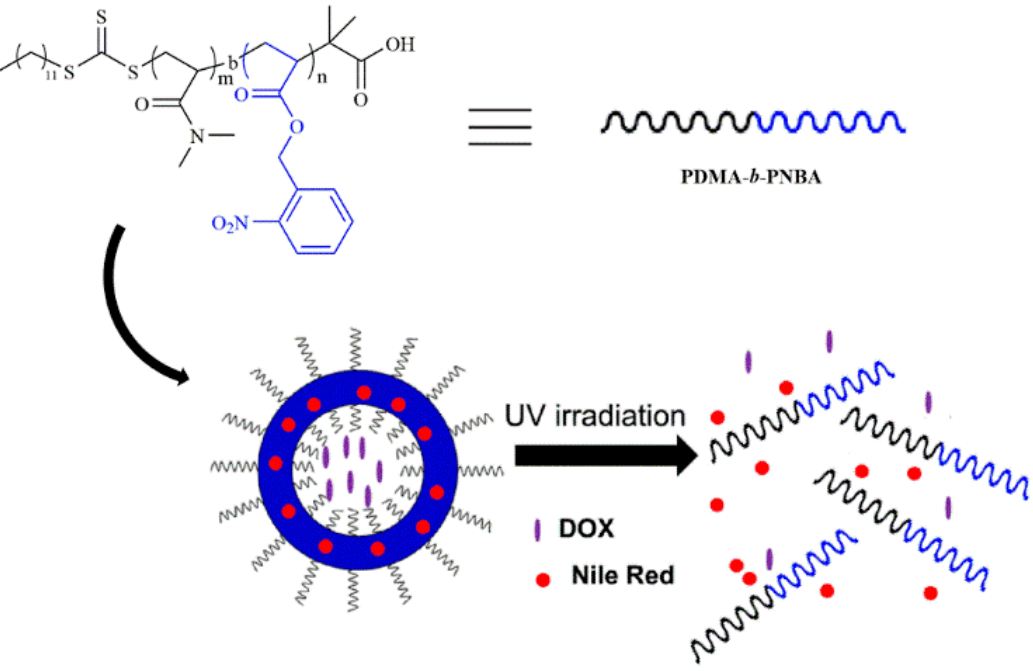
Scheme 1. Schematics for the controllable light-responsive co-release of hydrophobic and hydrophilic drugs from the developed polymersomes of PDMA -b- PNBA. DOX: doxorubicin; PDMA -b-